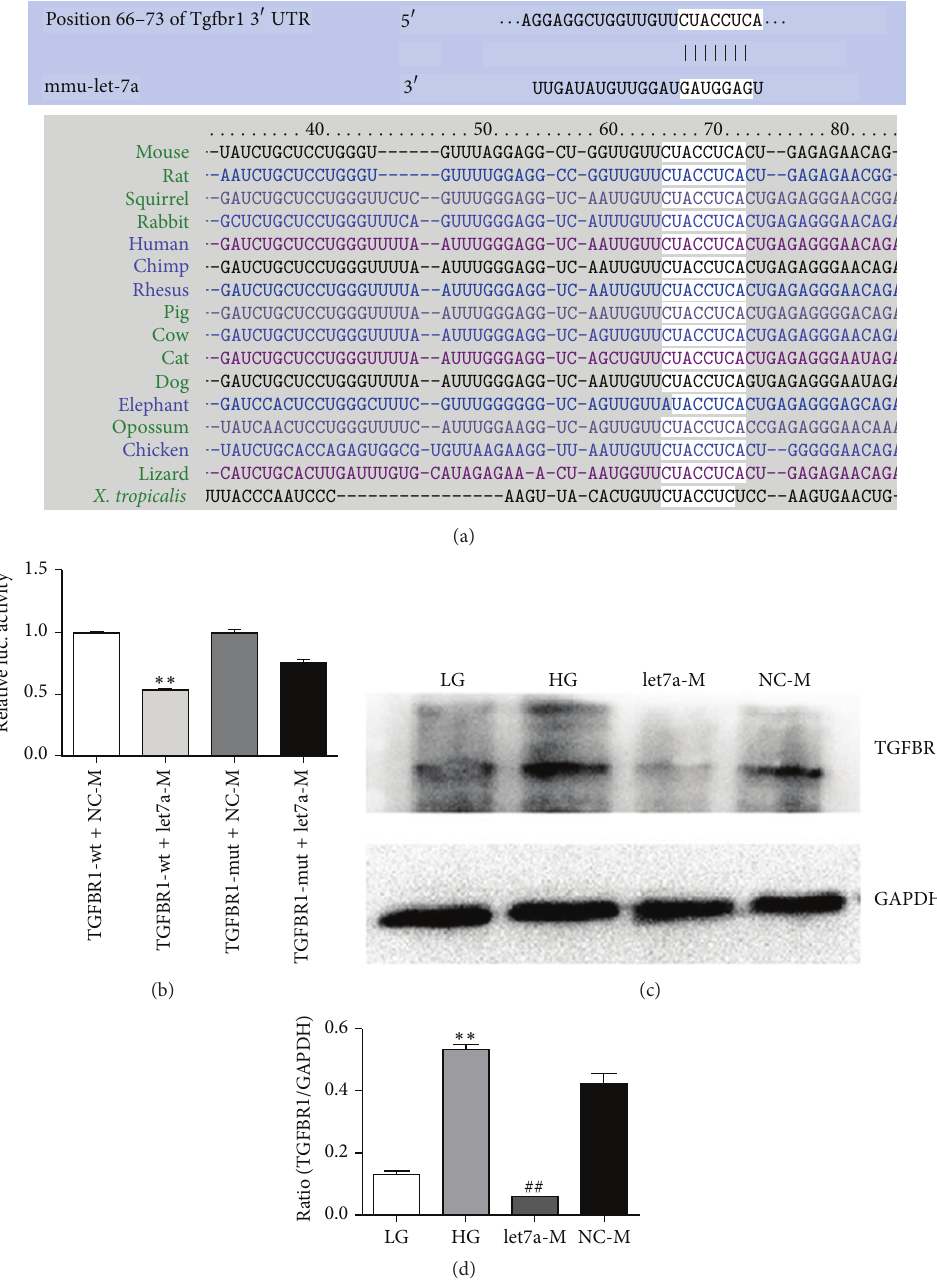
Figure 4: TGFBR1 was a target for let-7a. (a) Let-7a binding region of the 3 󸀠 -UTR of TGFBR1 from fifteen species. Paired bases were exhibited by a black line. And the binding site was boxed with a black rectangle. (b) Luciferase activity of reporters in the presence or absence of let- 7a mimics in 293T cells. Luc activity was significantly decreased in TGFBR1-wt+let7a-M. (c) Let-7a negatively regulated the expression of TGFBR1 in MMCs by western blot. (d) Quantifications of the western blot bands. (b) Data shown as mean ± standard deviation ( 𝑛 = 3 per group). ∗∗ 𝑝 < 0.01 versus TGFBR1-wt+NC-M group. (d) Results were normalized with GAPDH and expressed as mean ± standard deviation ( 𝑛 = 3 per group). ∗∗ 𝑝 < 0.01 versus LG group; ## 𝑝 < 0.01 versus HG